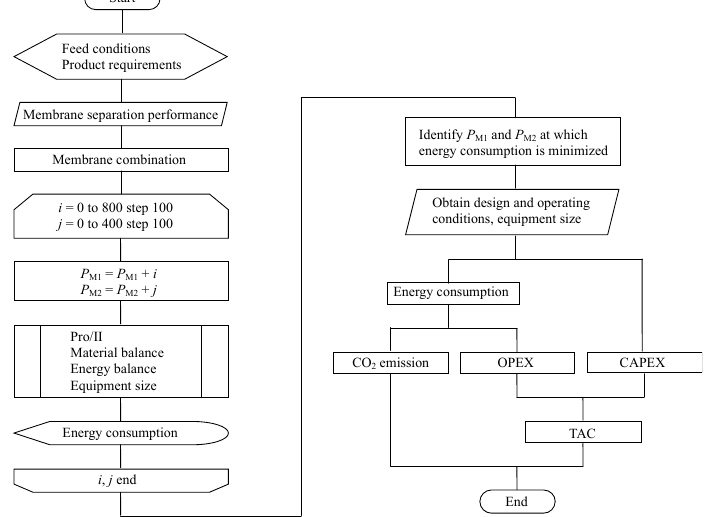
Figure 3. Design and evaluation scheme of the membrane-separation process.